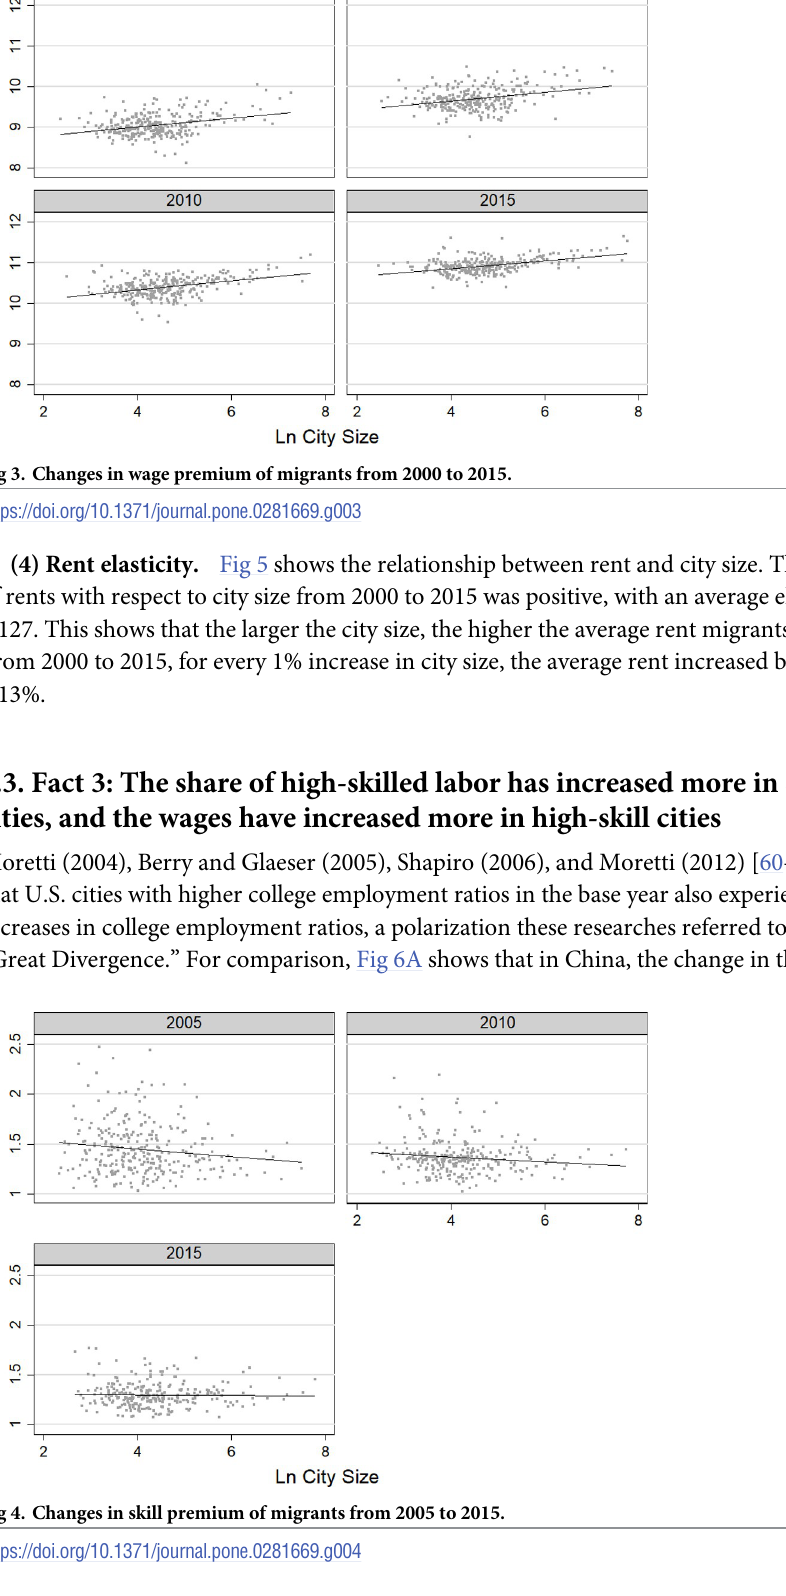
Fig 4. Changes in skill premium of migrants from 2005 to